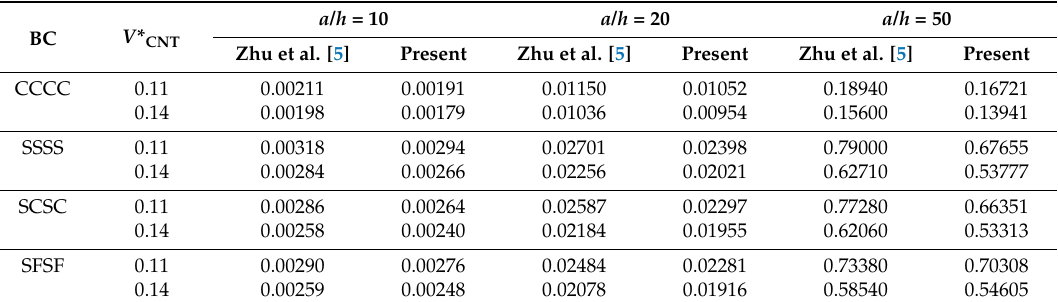
Table 9. Comparison study of non-dimensional maximum deflection of various volume fraction of UD CNT-reinforced composite